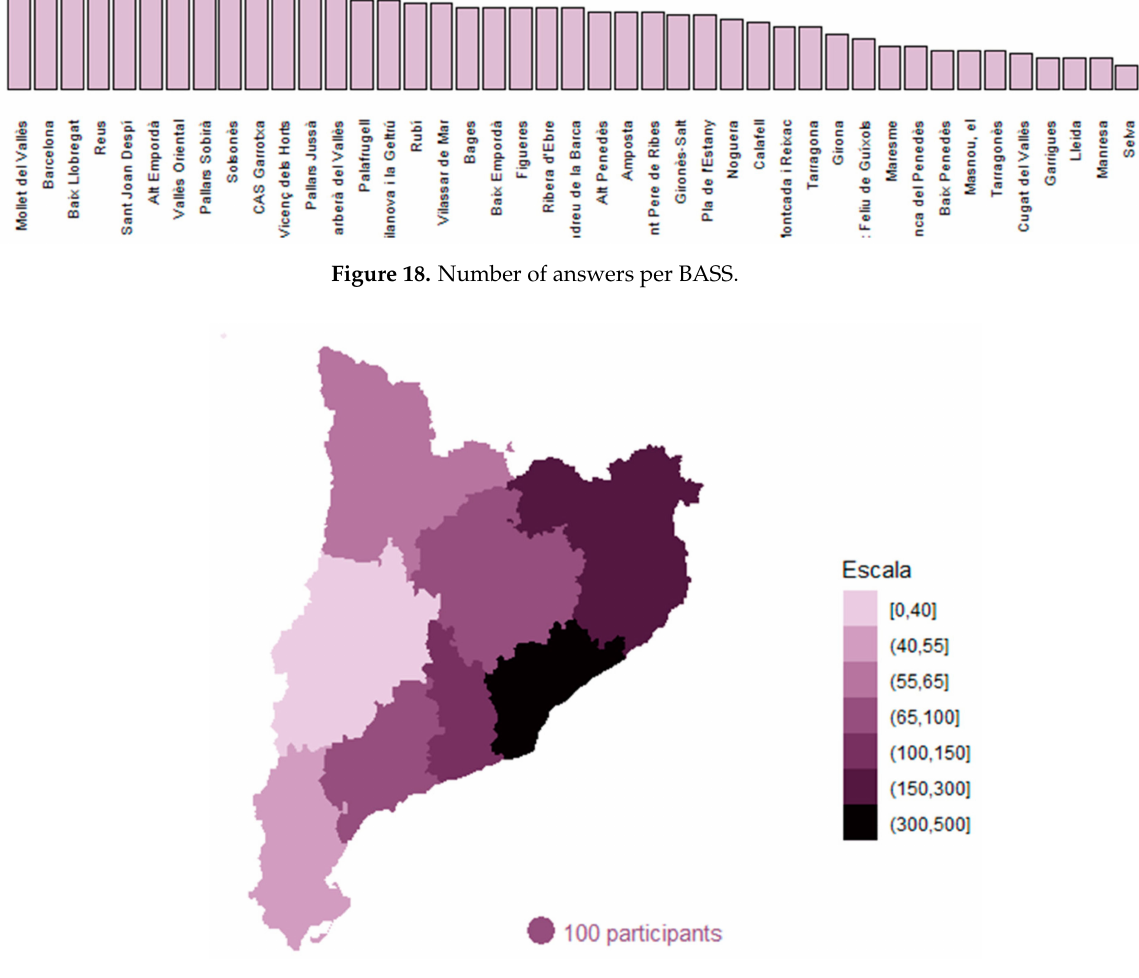
Figure 19. Number of answers per Vegueria.